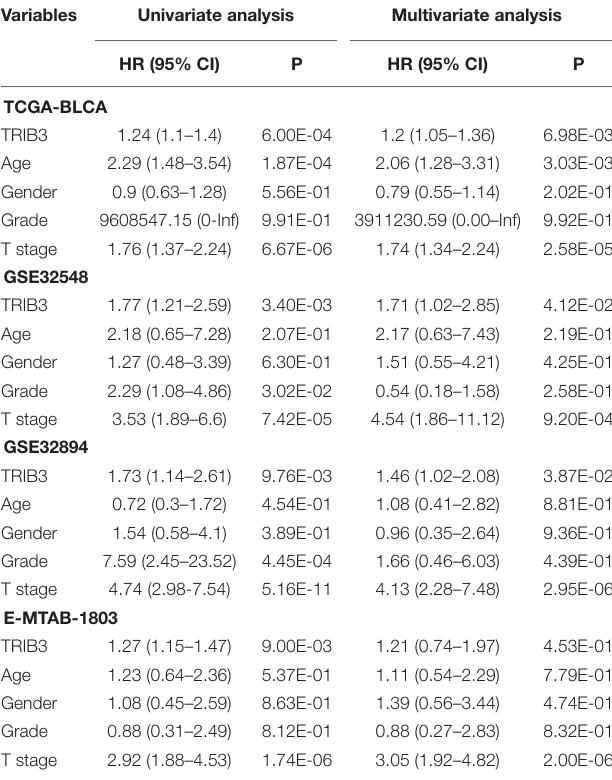
TABLE 2 | Univariate and multivariate Cox regression analysis of clinical-factors/TRIB3 with overall survival rate in